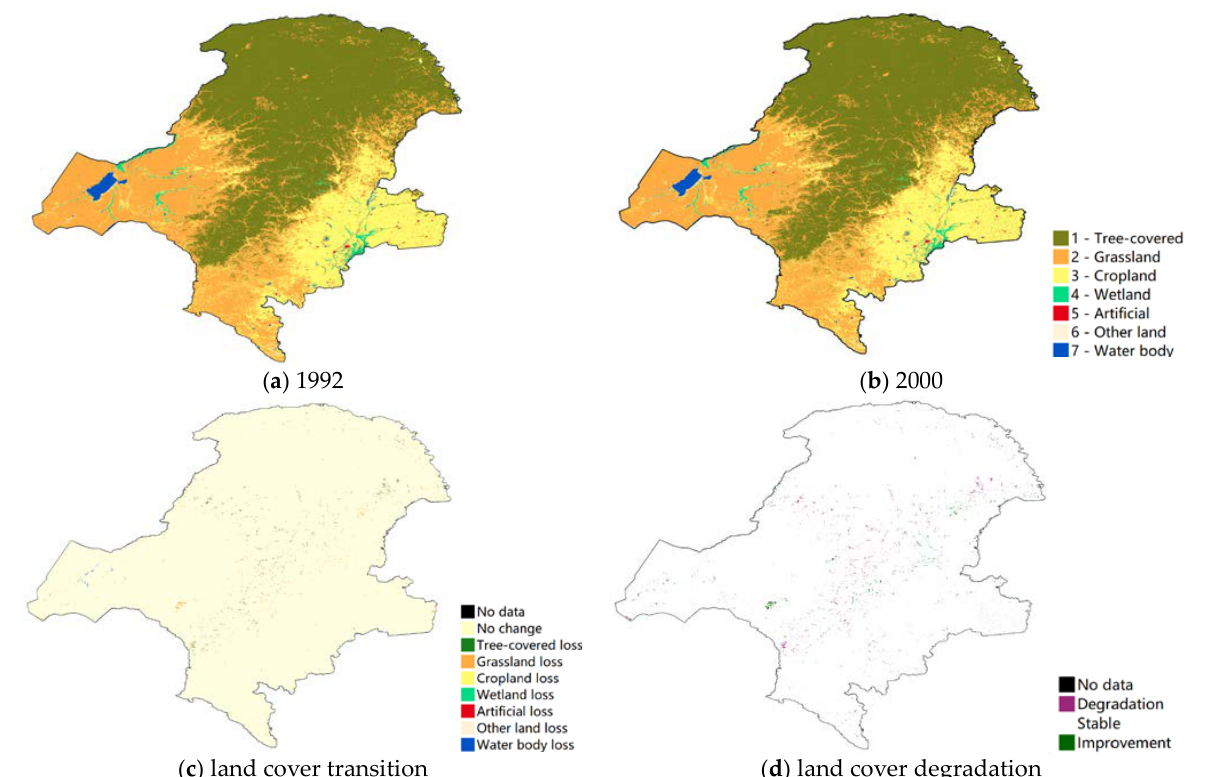
Figure 3. Land cover change and degradation in Great Khingan Mountain (GKM), China (1992–2000).